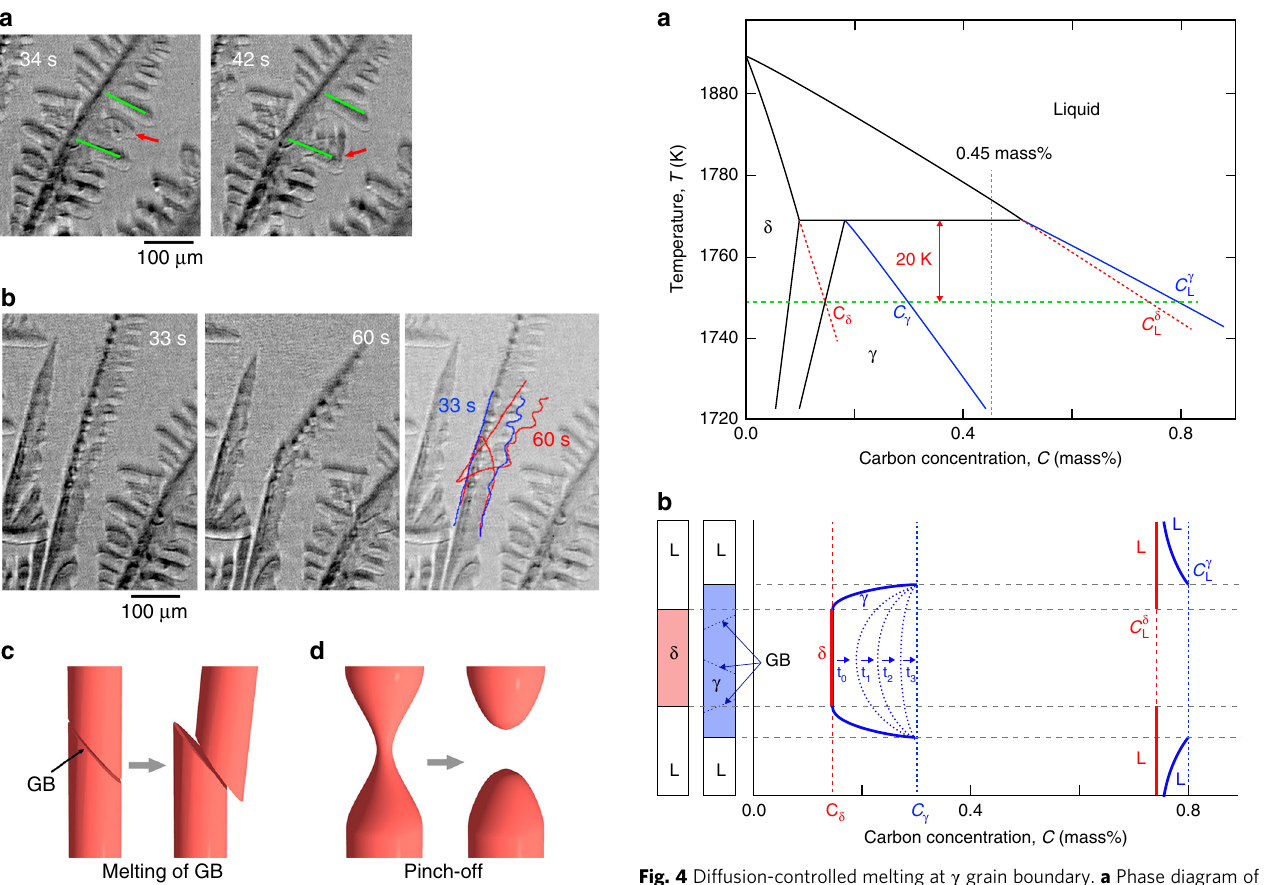
boundary if the transformation occurred in the δ phase after solidi fi cation.